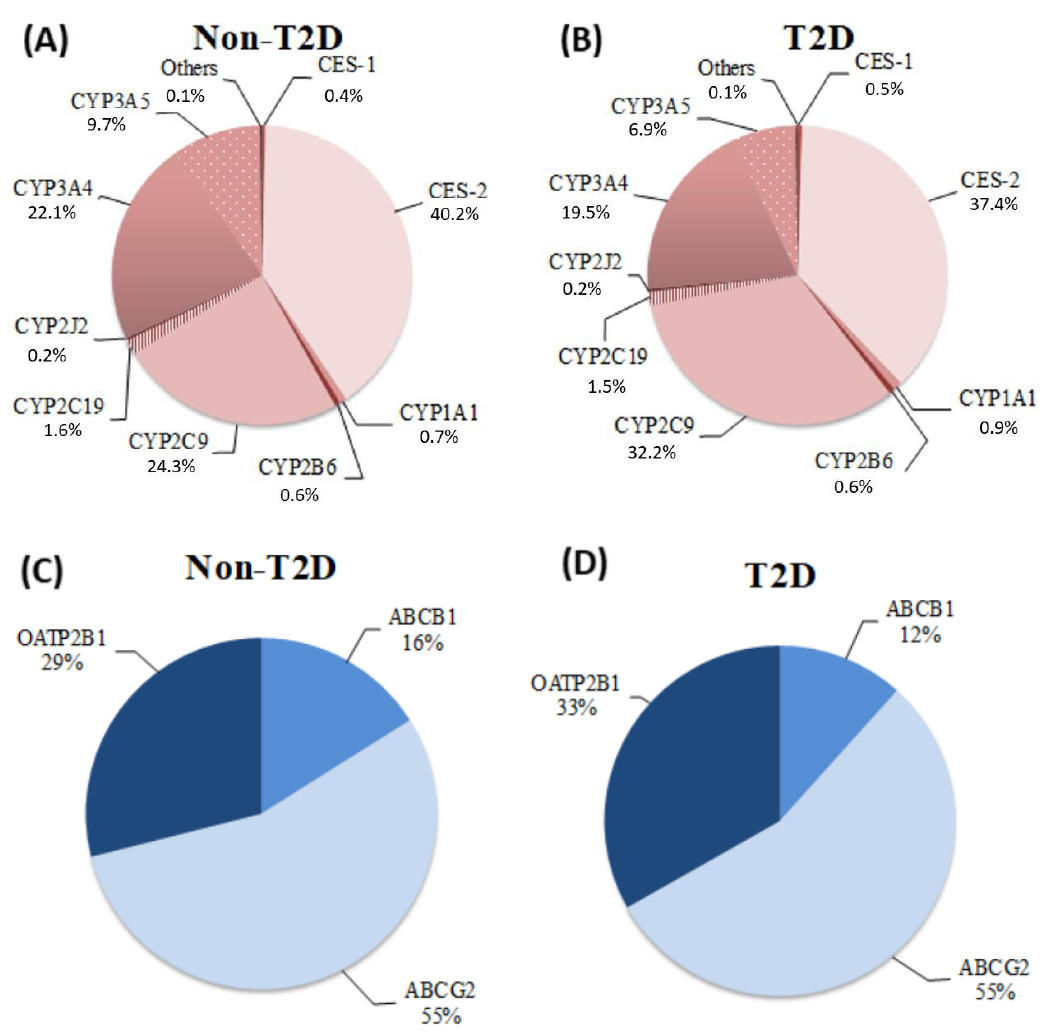
Figure 1. Drug metabolizing enzymes and transporters’ relative mRNA expression levels. Total mRNA transcripts (2 − ∆ C T ) for each drug metabolizing enzymes (CYP450s and CES) and drug-transporters are displayed as expressed in human duodenal biopsies according to study group: ( A ) relative mRNA expression of drug metabolizing enzymes in non-T2D patients ( n = 15). ( B ) Relative mRNA expression of drug metabolizing enzymes in T2D patients ( n = 20). ( C ) Relative mRNA expression of drug-transporters in non-T2D patients ( n = 15). ( D ) Relative mRNA expression of drug transporters in T2D patients ( n = 20). CYP450 mRNA transcript with a relative contribution > 0.2% are illustrated, and “others” have a relative contribution ≤ 0.07%. Others include the following isoforms: CYP2C8, CYP2D6, and